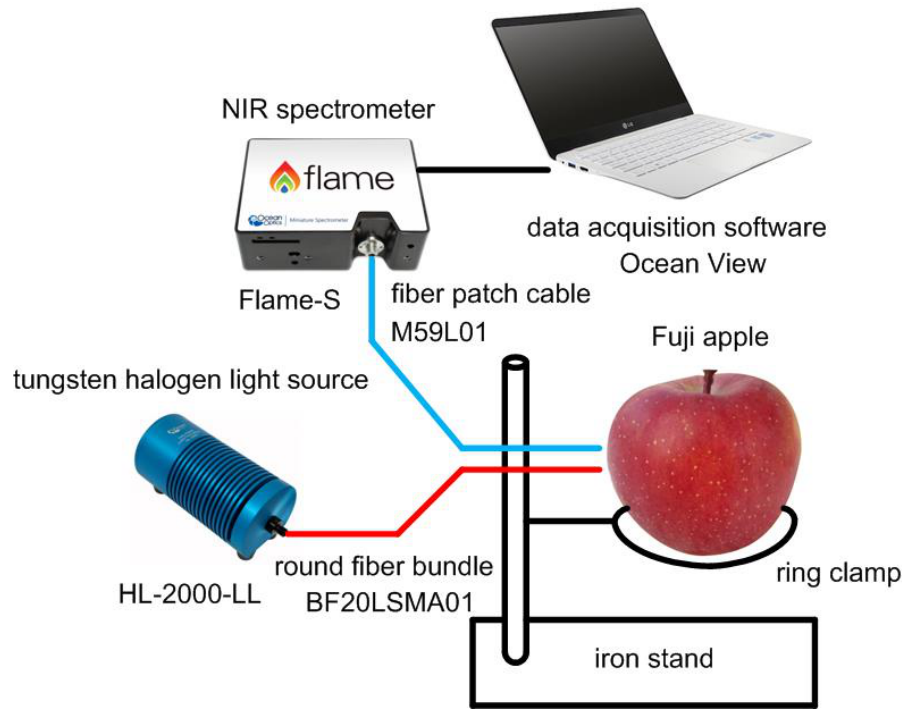
Figure 1. Sugar content measurement setup using an NIR spectrometer.